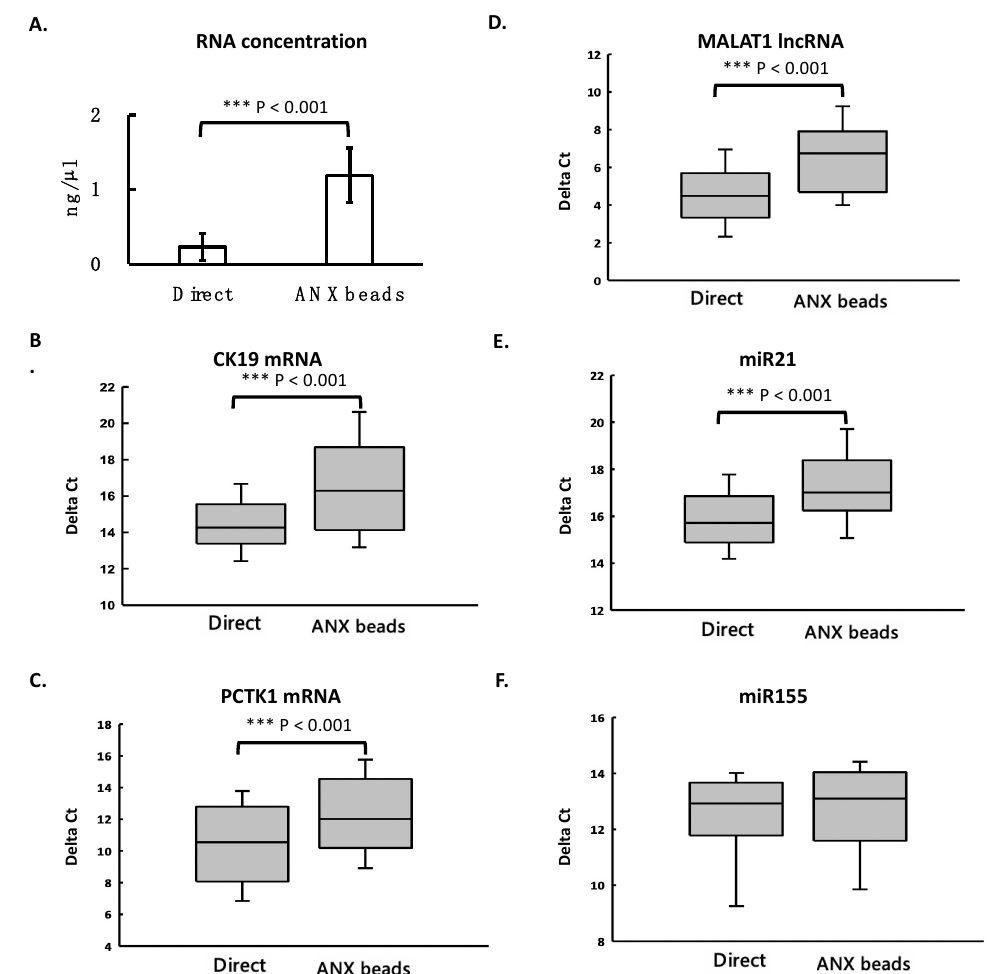
Figure 5. ANX beads increased exRNA recovery from plasma samples. The plasma samples (n = 50) were either subjected to RNA extraction directly or first mixed with ANX beads to capture EVs and then subjected to RNA extraction. Total RNA concentration was determined by a fluorometer ( A ). The levels of different RNA species were measured by RT-qPCR. These RNA species included mRNAs-CK19 and PCTK1 ( B , C , respectively), lncRNA-MALAT1 ( D ), and miRNAs-miR21 and miR155 ( E , F , respectively). Student’s t -test was used for statistical analysis. Results were considered significant at p < 0.05. *** p <